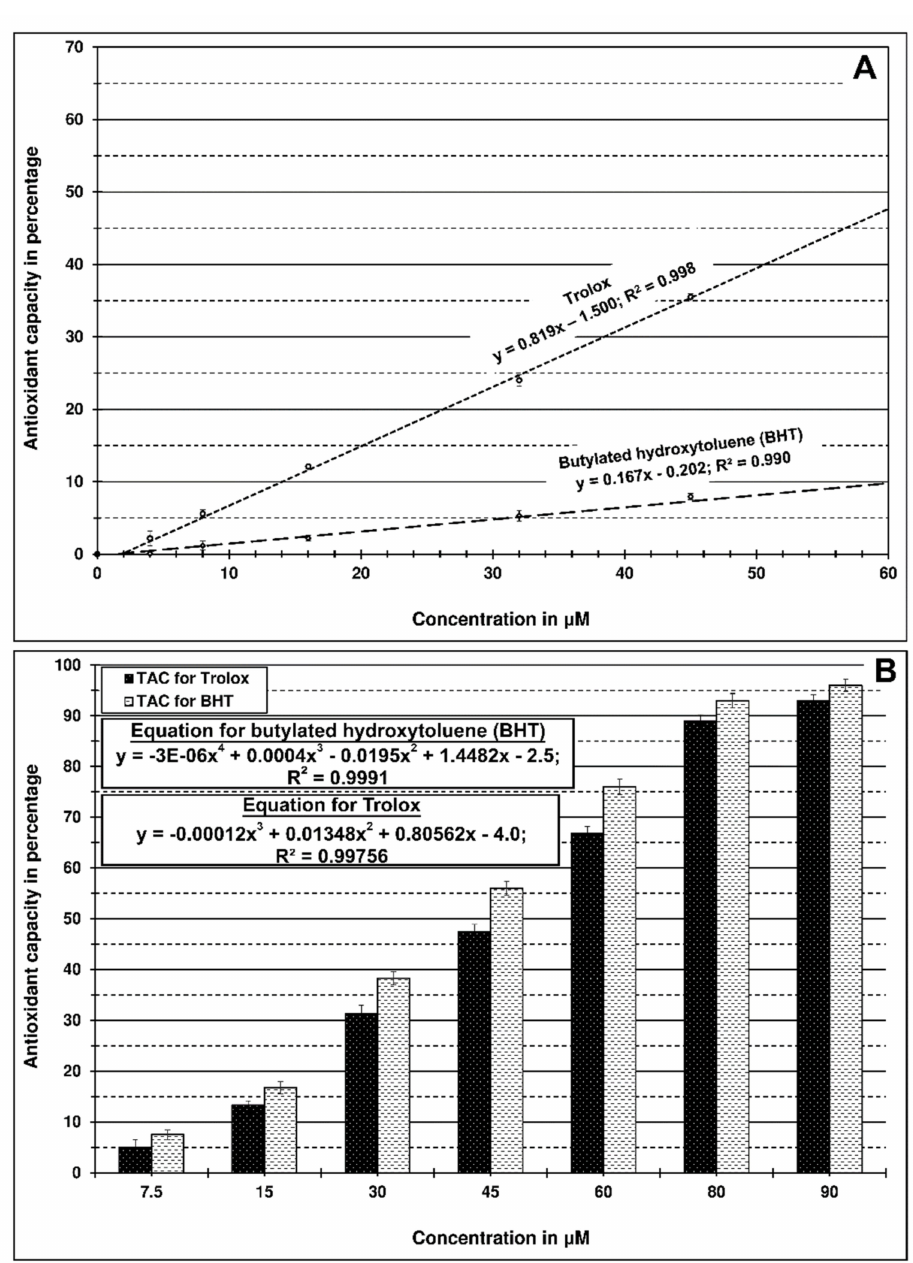
Figure 4. Antioxidative capacity of synthetic trolox and bytylated hydroxytoluene used as positive control; ( A )—against DPPH radical, ( B )—against ABTS